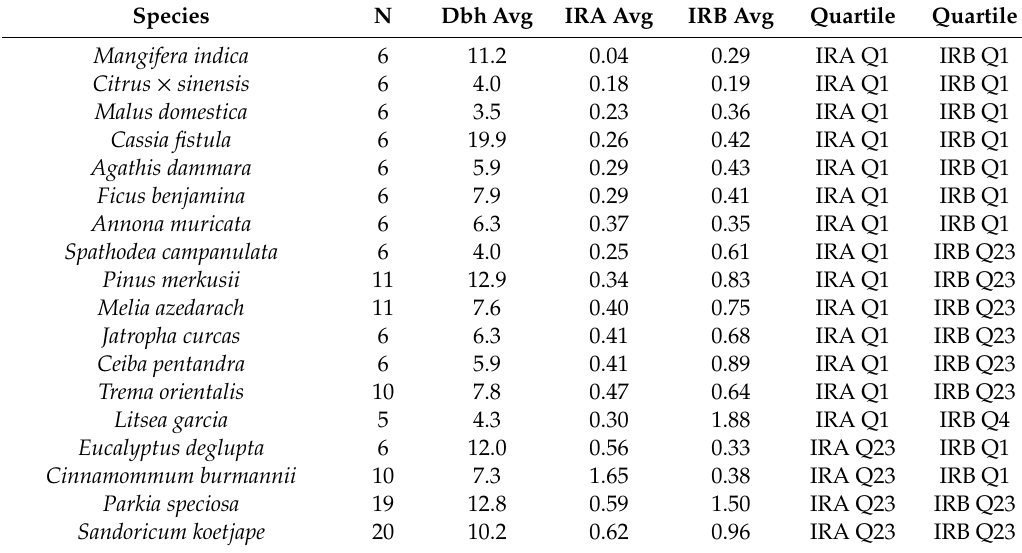
Table A1. Root observations across six sites, with number of trees observed (N), average dbh, IRA, and IRB, and quartiles in IRA and IRB